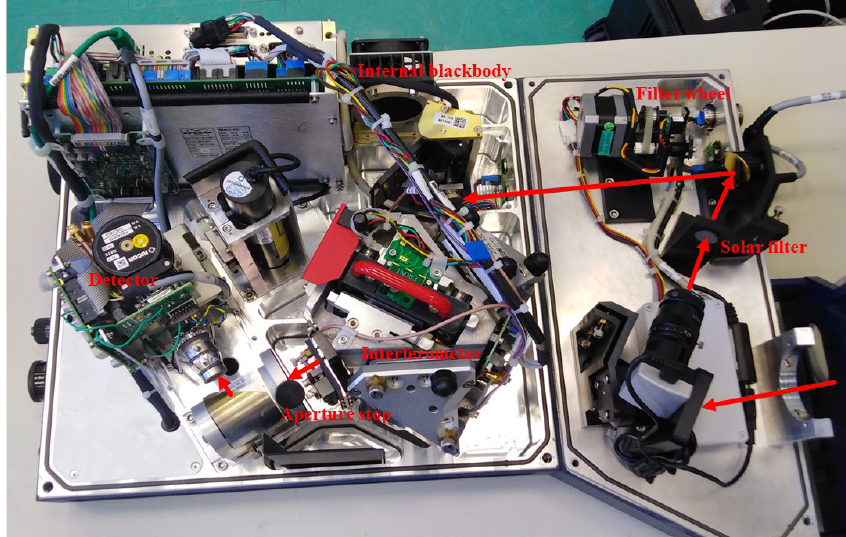
Figure 1. An internal look at CHRIS. The red arrows illustrate the optical path of the solar beam inside the